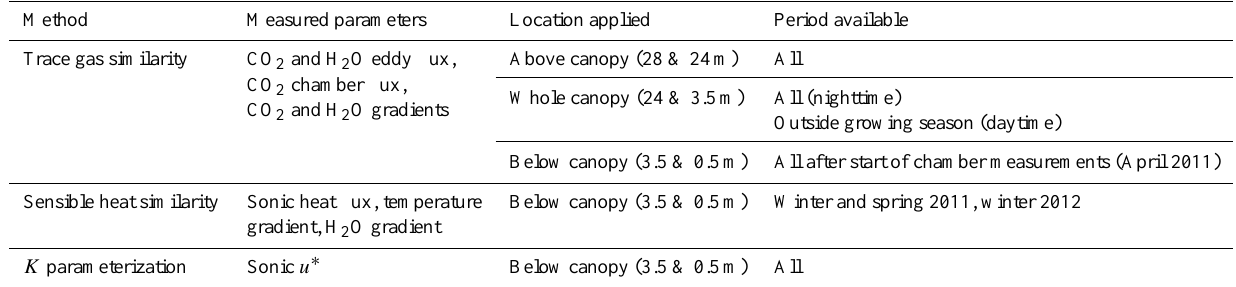
Table 1. The type, location, and availability of the ancillary measurements required for each flux-gradient method.